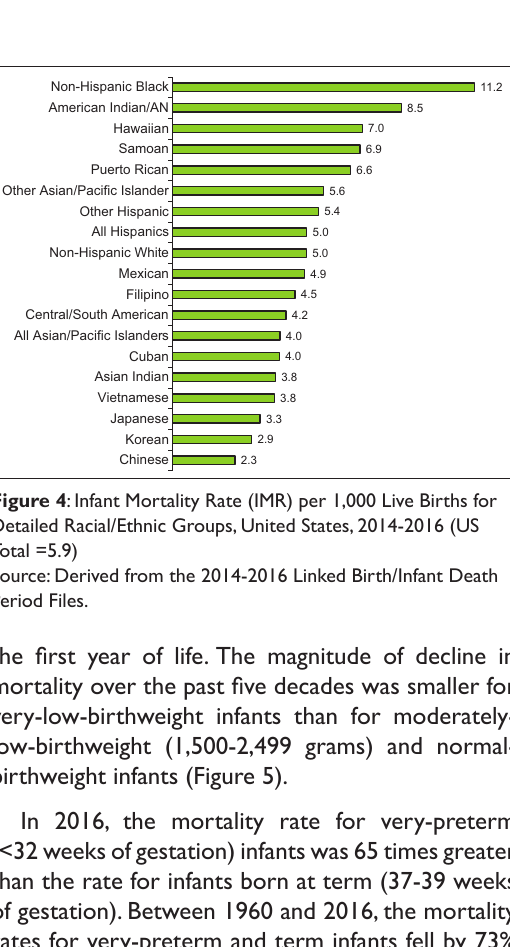
a Figure 3 : (a) Neonatal and Postneontal Mortality Rates by Race, United States, 1916-2017. (b) Black/White Ratios of Neonatal and Postneonatal Mortality Rates, United States, 1916-2017 Source: US National Vital Statistics System.